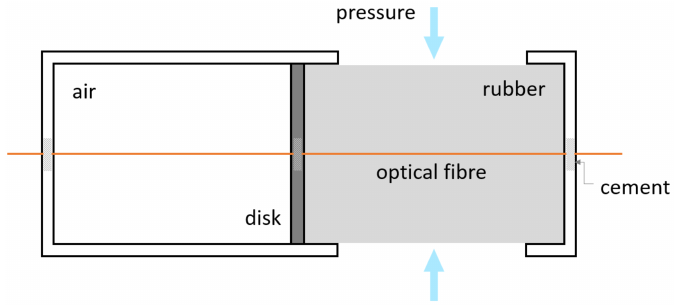
Figure 15. Diagram demonstrating the geometry of an FOS described in